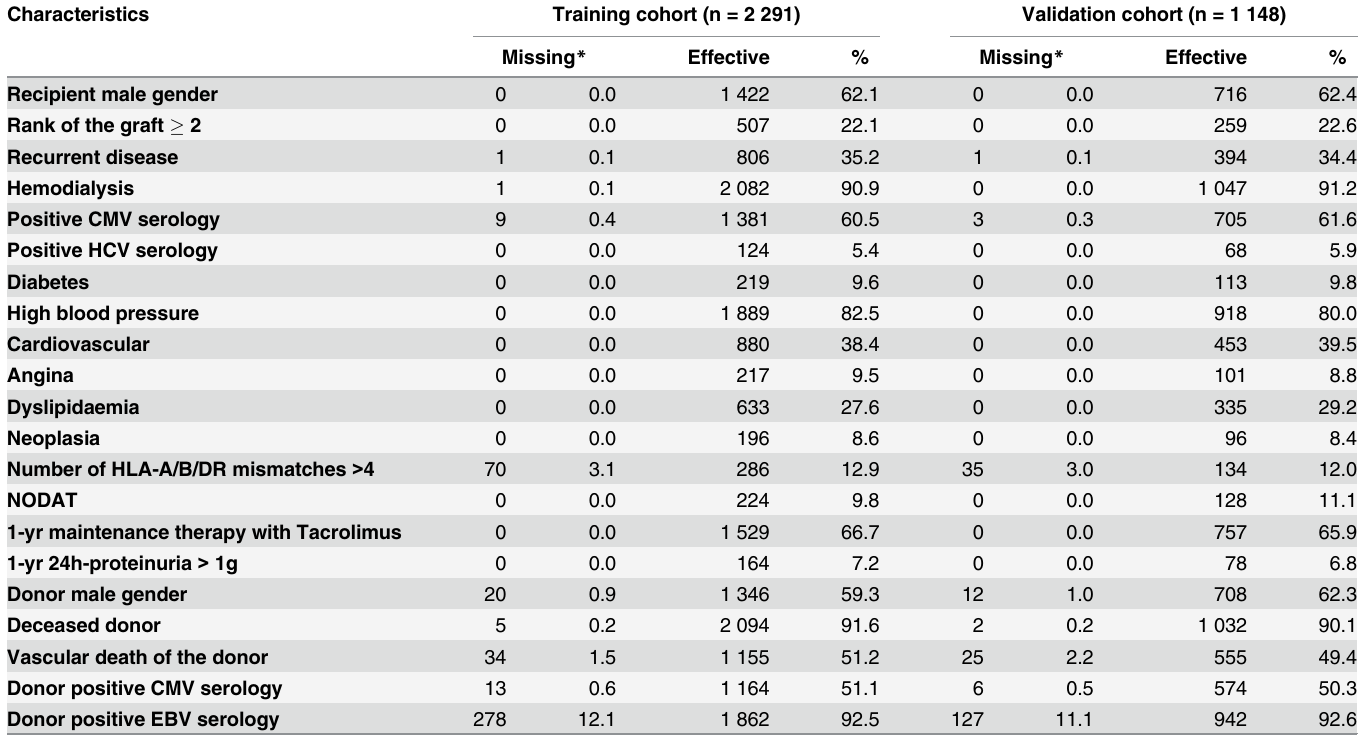
Table 2. Recipient, transplantation and donor qualitative characteristics at transplantation or at 1-year of transplantation of the training and valida- tion samples (effective, standard deviation and missing values).